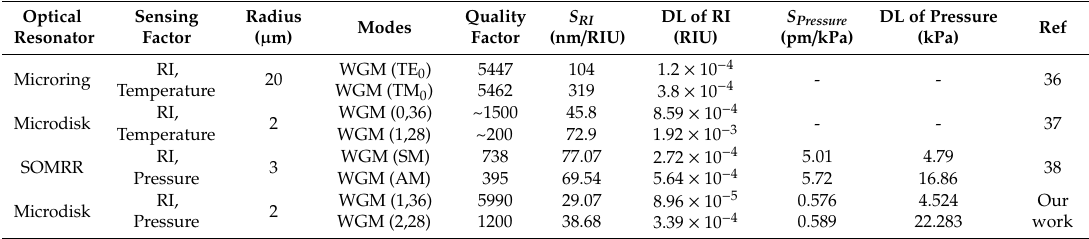
Table 2. Comparisons of Sensing Performance of Dual-Sensing Optical